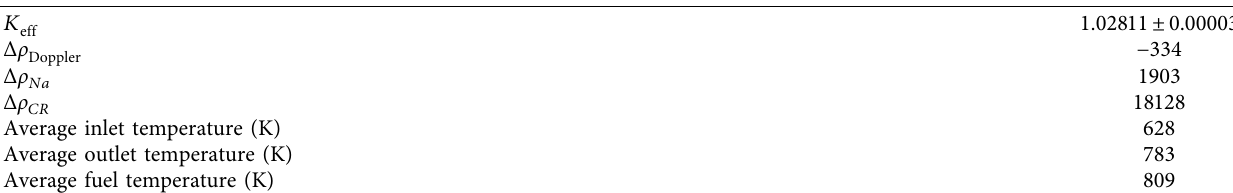
Figure 13: (a) Power distribution and (b) temperature distribution along the axis of the second fuel in the corner. Table 4: Results of MET-1000 before